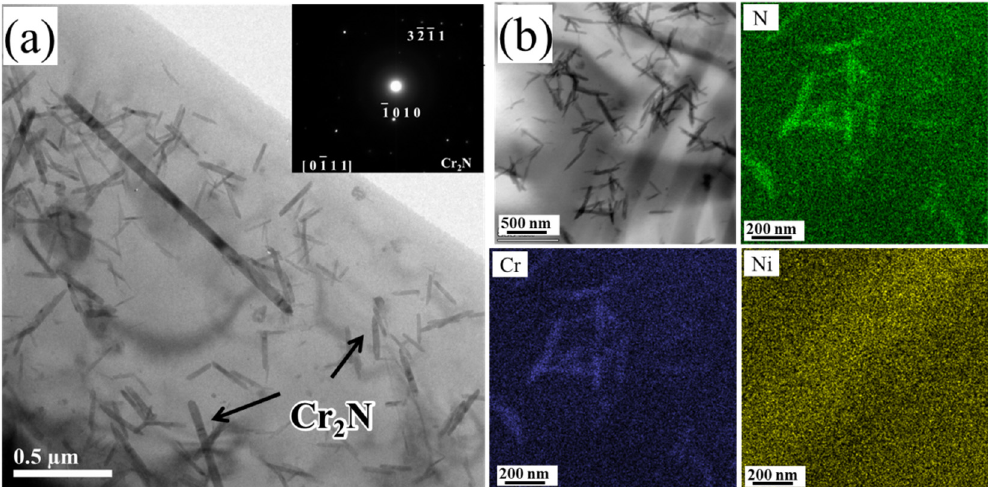
Figure 9. TEM observation and EDS maps of the TS samples of the weld metal: ( a ) TEM and ( b ) EDS.